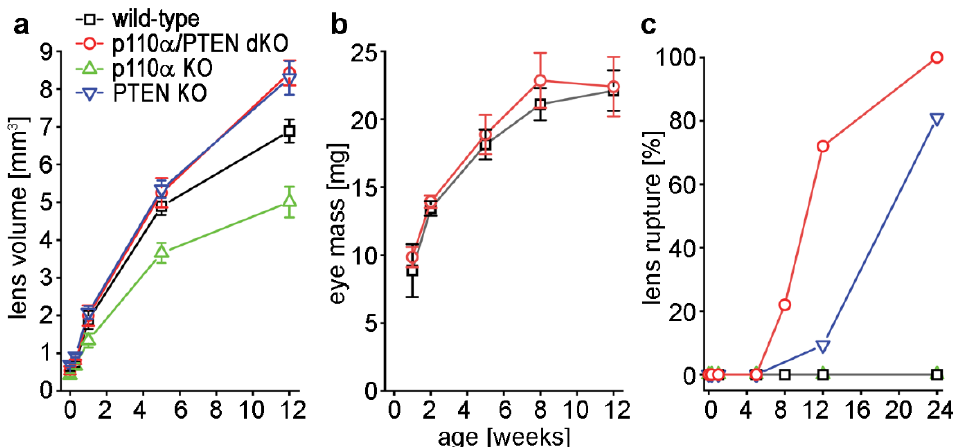
Figure 2. Double deletion of p110 α /PTEN eliminated the growth defect of single p110 α KO mice, and accelerated the rupture phenotype of single PTEN KO animals. ( a ) Diameters of lenses dissected from WT, p110 α KO, PTEN KO and p110 α /PTEN dKO mice at P0, P2, and 1, 5, or 12 weeks of age were used to calculate lens volume. The volumes of dKO lenses were similar to single PTEN KO lenses [14] at all ages. In contrast, the reduced lens volume reported for single p110 α KO lenses [13] was absent. ( b ) Eye mass was not increased in dKO lenses when compared to WT. ( c ) The incidence of lens rupture versus age for WT, p110 α KO, PTEN KO, and p110 α /PTEN dKO mice at P0, P2, and 1, 5, 8, 12, and 24 weeks. Lens rupture was accelerated in dKO animals compared to single PTEN KO mice. No rupture was observed in wild-type or single p110 α KO lenses. Data are plotted as mean ± SD. See Table S1 for a detailed breakdown of the number of lenses (4–64) analyzed per genotype per time point. See Table S2 for statistical comparison of dKO versus wild-type lens and eye growth per time